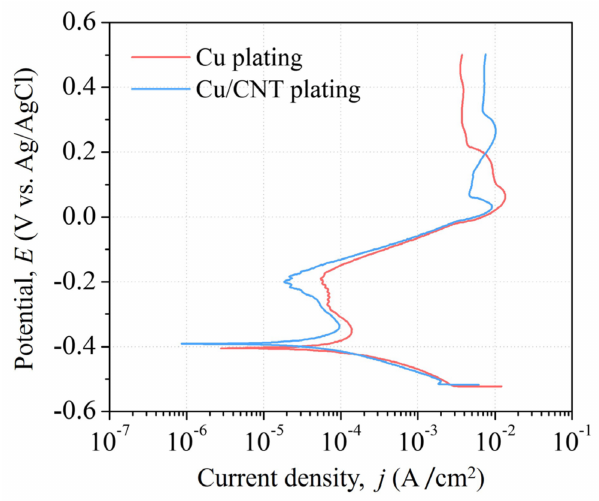
Figure 9. Anodic polarization curves for Cu and Cu/CNT plating measured in 3 mass% NaCl solution. Both platings are prepared by a pulse current density of − 30 mA/cm 2 . Table 2. Polarization parameters for Cu and Cu/CNT plating: corrosion potential ( E corr ),